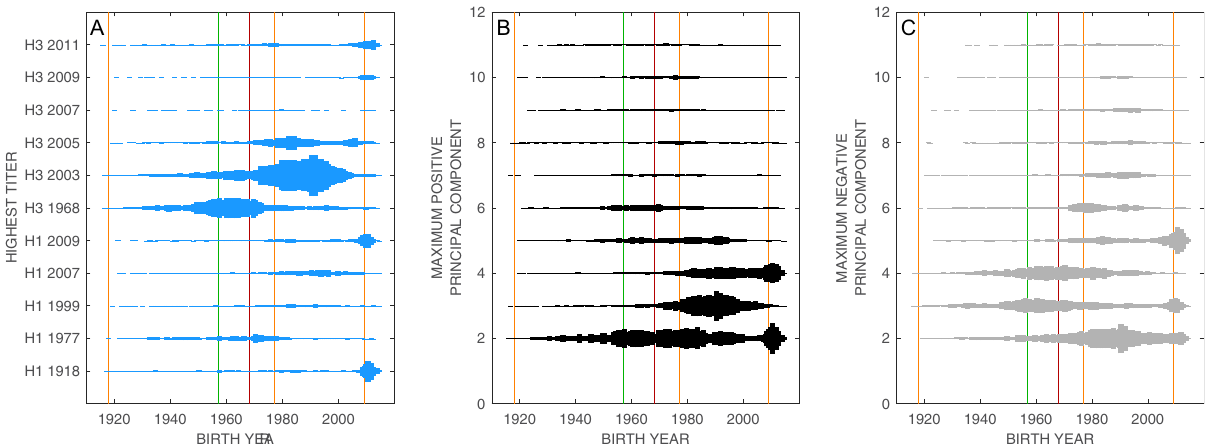
Fig. 4 Histograms showing how individuals are sorted by titer or principal component. Histograms showing how individuals are sorted by their A maximum antibody titer, B maximum positive principal component (excluding PC1), and C maximum negative principal component (excluding PC1). In each panel, each of the n = 24,402 individuals appears exactly once depending on their highest titer ( A ) or the maximum magnitude of their principal components ( B , C ). For example, most individuals born after 2009 have their maximum antibody titer to the 2011 H3N2 strain, the 2009 H1N1 pandemic virus, or the 1918 H1N1 in fl uenza virus. These same individuals have either principal component 2 or 4 as their largest magnitude component (among positive components). The vertical lines show the time of introduction of new subtypes into the population: H1N1 (orange), H3N2 (red), and H2N2